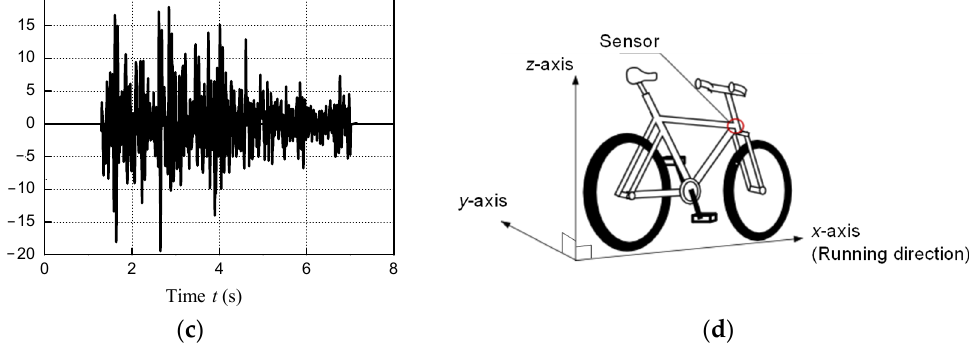
( d ) Figure 1. Acceleration distribution in a moving bicycle ( v = 10 km/h). ( a ) x -axis (moving direction); Figure 1. Acceleration distribution in a moving bicycle ( v = 10 km/h). ( a ) x -axis (moving direction); Figure 1. Acceleration distribution in a moving bicycle ( v = 10 km/h). ( a ) x -axis (moving direction); ( b ) y -axis; ( c ) z -axis; ( d ) Sensor position. ( b ) y -axis; ( c ) z -axis; ( d ) Sensor position. ( b ) y -axis; ( c ) z -axis; ( d ) Sensor position. Figure 1. Acceleration distribution in a moving bicycle ( v = 10 km/h). ( a ) x -axis (moving direction); ( b ) y -axis; ( c ) z -axis; ( d ) Sensor position.